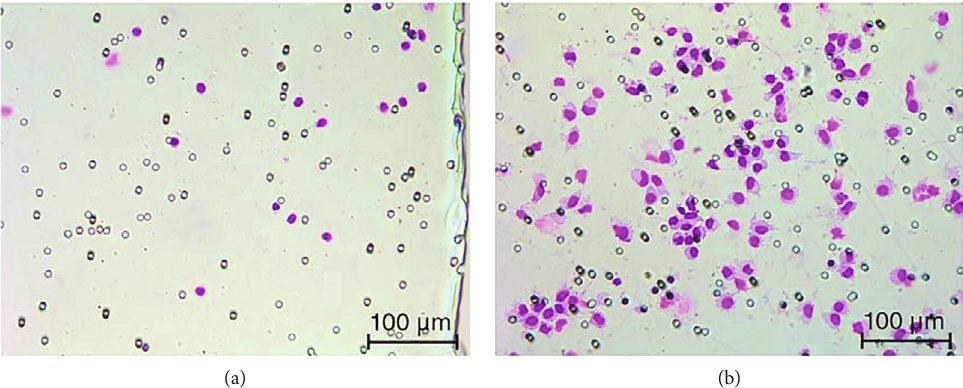
Figure 4: A representative micrograph showing migrated peripheral blood mononuclear cells (PBMCs) on the lower surface of porous membrane after stimulation for 48 hours with (a) diluent control or (b) 25 μ g/ml iC3b. The PBMCs, stained with May-Grünwald- Giemsa, were from the subject F29. The cells in Figure 4(b) belong mostly to the monocytic lineage, though they cannot be distinguished with absolute certainty from lymphocytes.